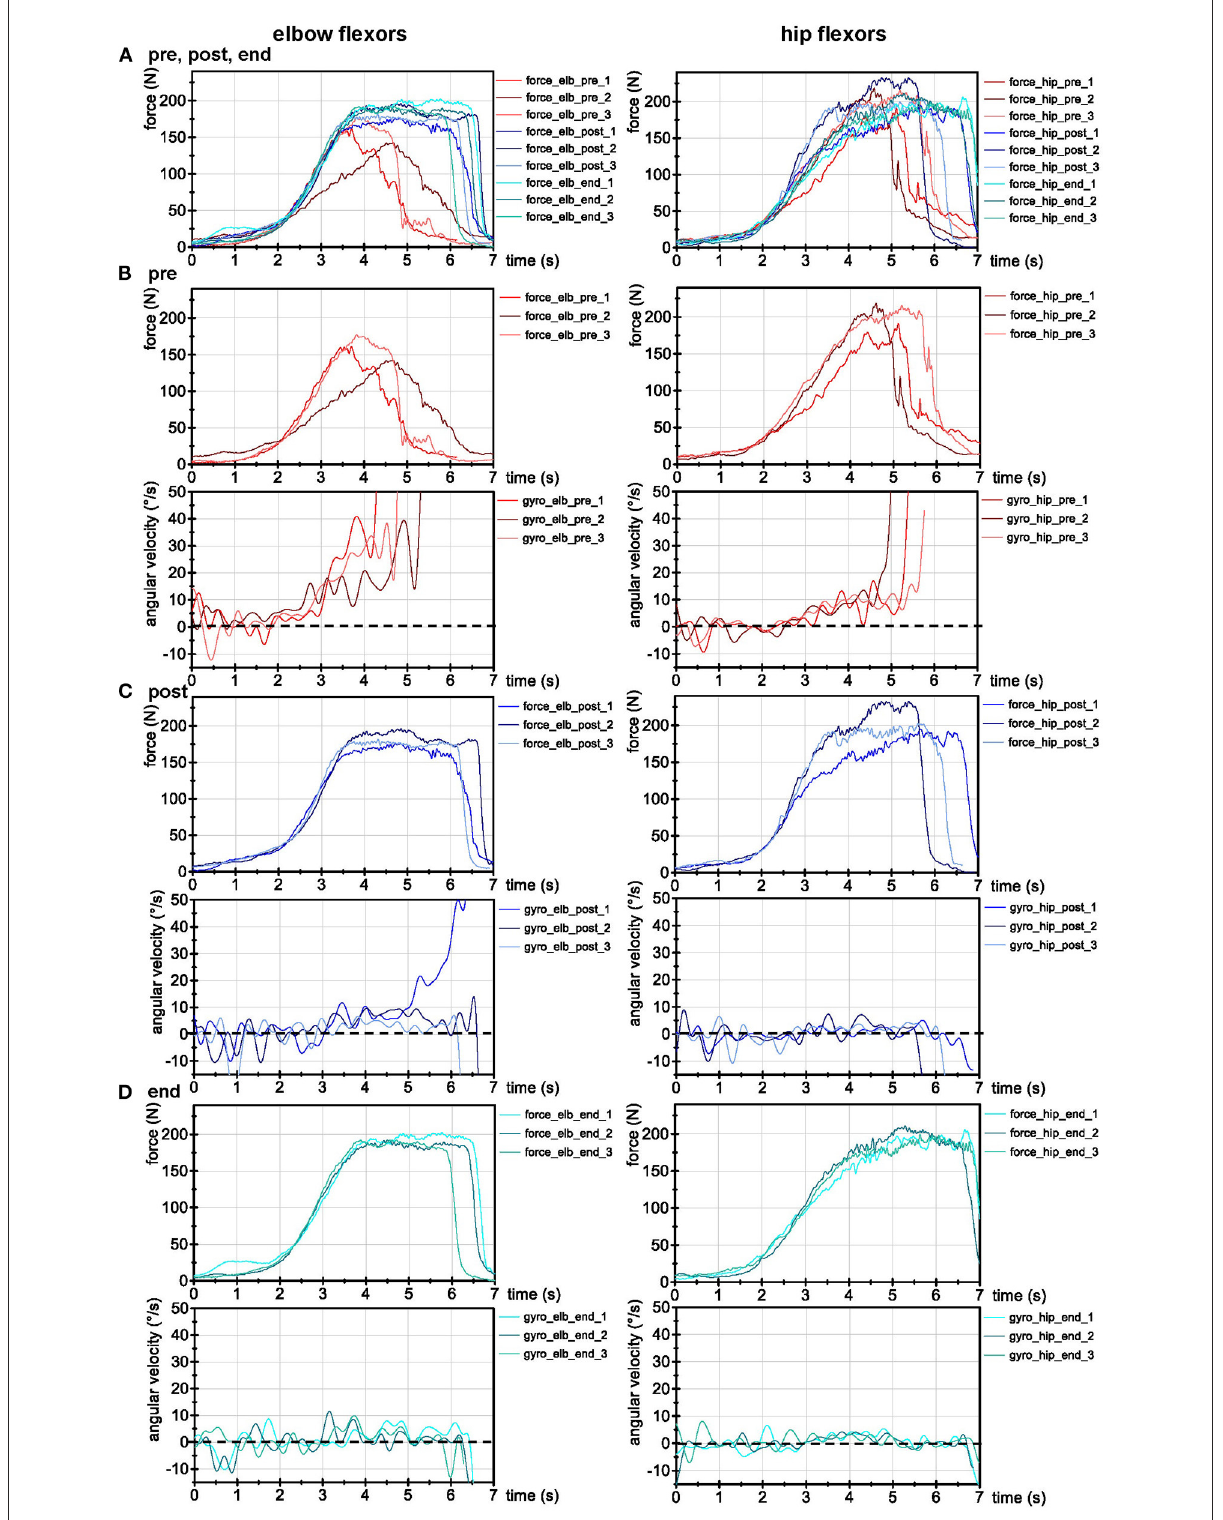
FIGURE2 AF recordings of left elbow and hip flexors. (A) Force (N) of all trials before (pre), directly after (post) and 4 weeks after treatment (end). (B) Force (N) and angular velocity ( ◦ /s) of AF recordings pre-treatment, (C) directly post-treatment, and (D) 4-weeks post-treatment (end). All signals were filtered (butterworth; force: filter degree 5, cut-off frequency: 20 Hz; angular velocity: filter degree: 10, cut-off: 3 Hz). Dotted lines indicate zero for angular